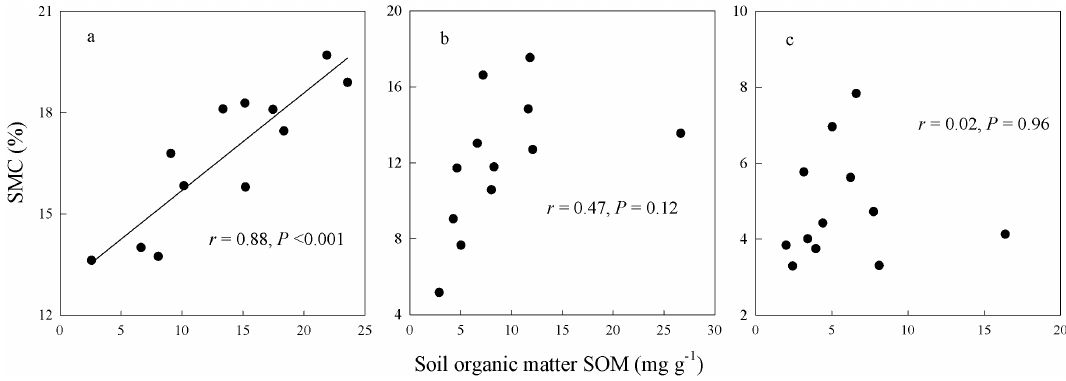
Fig. 7. Correlations between the SMC (soil moisture content) and SOM (soil organic matter) in watersheds (a) W1, (b) W2 and (c) W3.